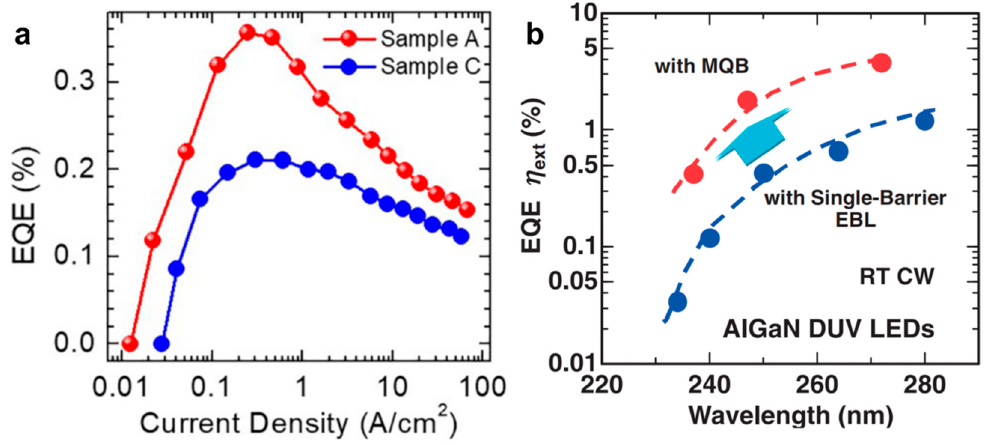
Figure 6. ( a ) Current density dependent EQE under CW bias. Sample A includes an EBL graded from an Al composition of ~95% to ~75%. Sample C is identical to Sample A, except that its EBL is a uniform Al 0.75 Ga 0.25 N:Mg layer with the same thickness [36]. ( b ) The EQE of DUV LEDs with different wavelength with an MQB and a single barrier EBL [85].